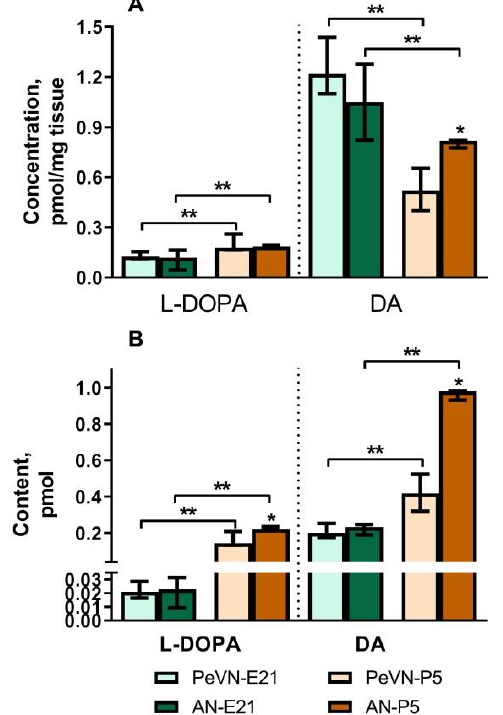
Figure 1. Concentration ( A ) and content ( B ) of dopamine (DA) and L-3,4-dihydroxyphenylalanine (L-DOPA) in the periventricular nucleus (PeVN) and in the arcuate nucleus (AN) on embryonic day 21 (E21) and on postnatal day 5 (P5). * p < 0.05, significant differences in the concentration and content of DA in the PeVN and AN; ** p < 0.05, significant differences between the selected parameters (unpaired Wilcoxon test). Data are presented as median with interquartile range.